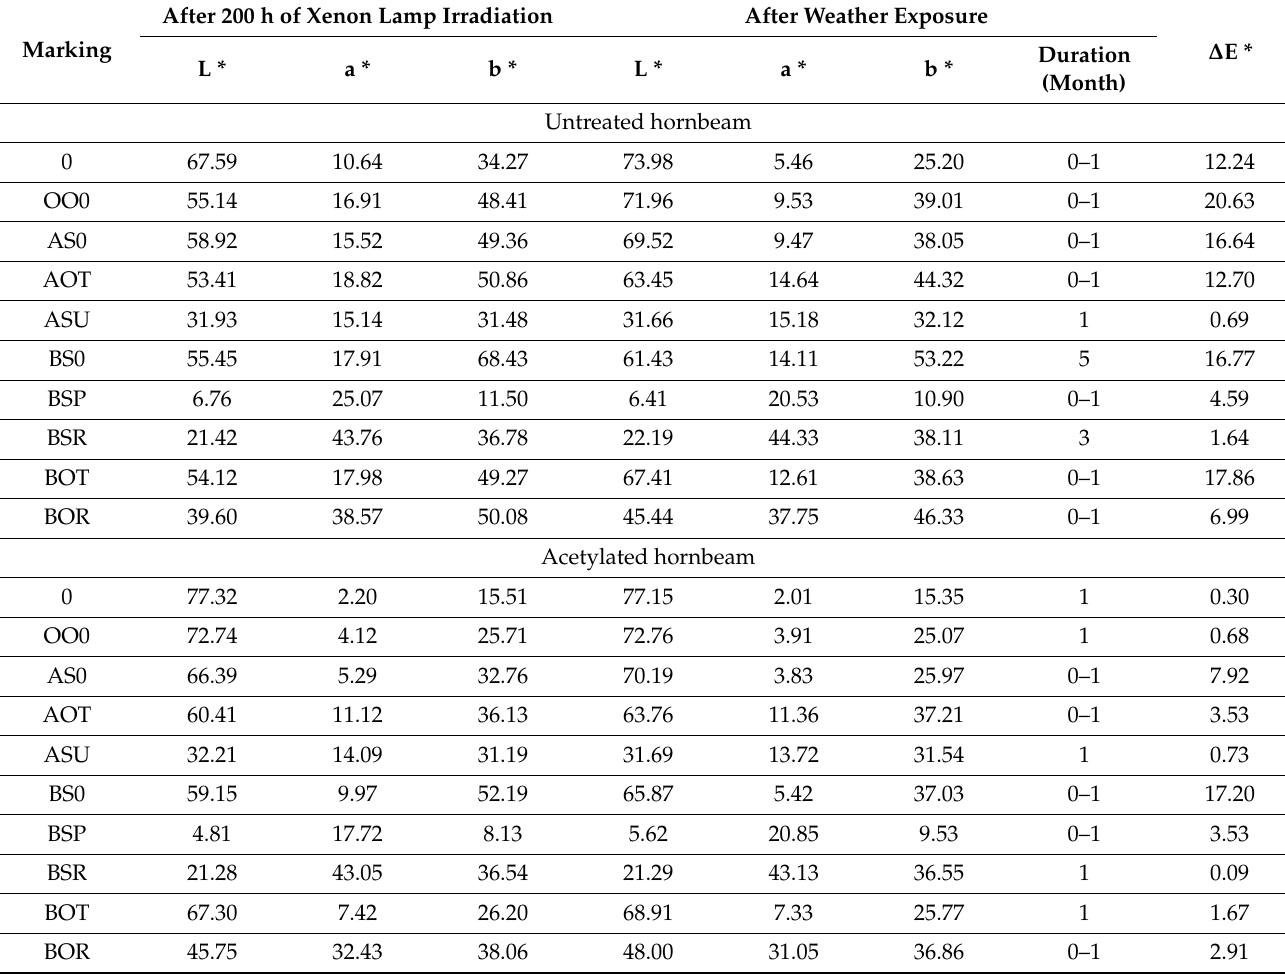
Table 7. Defining the length of weather exposure needed to achieve similar color change of 200-h-long xenon lamp